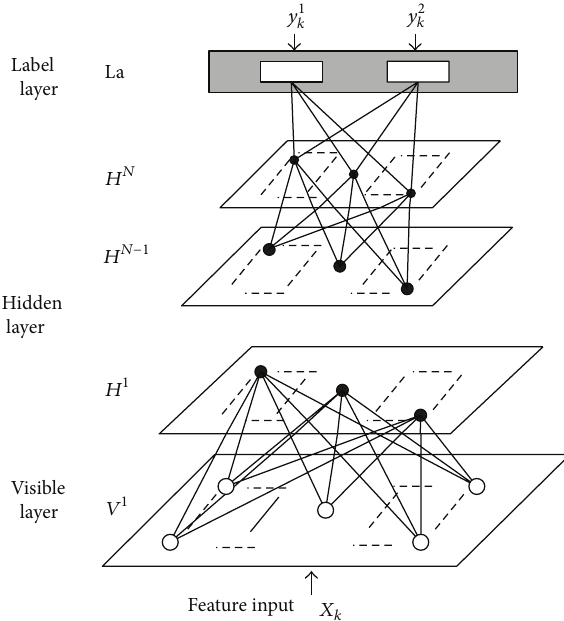
Figure 2: Proposed 2D-DBN for vehicle